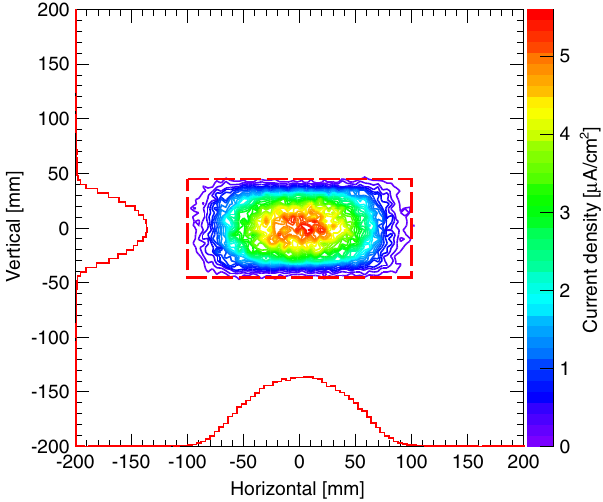
FIG. 16. Calculated beam profile at neutron production target with octupole magnet and muon production